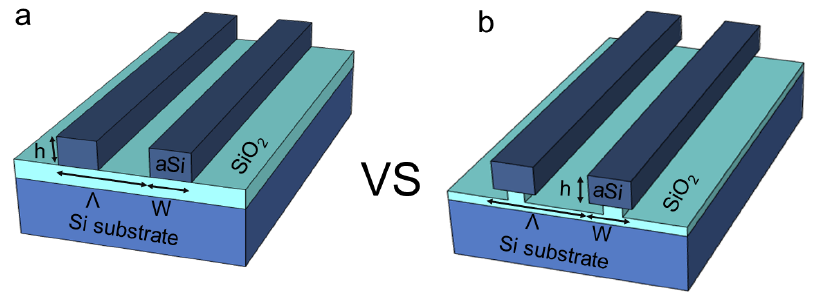
Figure 1. Schematic illustration cross-section of ( a ) conventional and ( b ) pedestal high-contrast gratings. The structural parameters of the gratings are defined by period Λ , grating height h and grating width W .